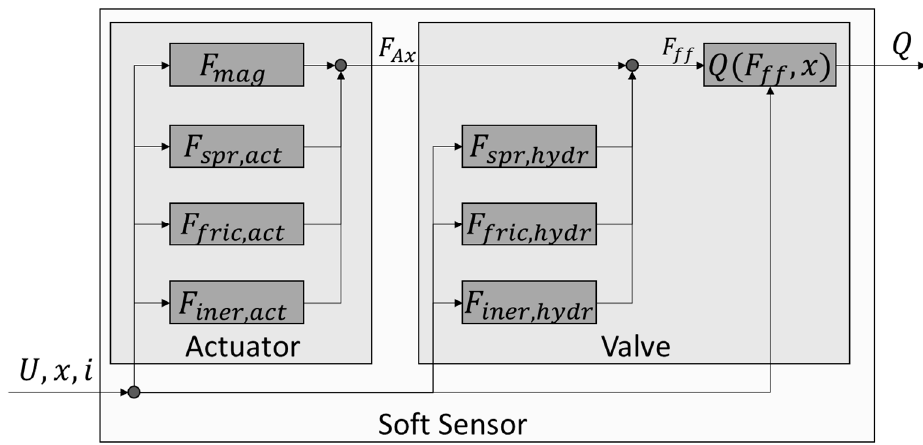
Figure 3. Conceptual Structure of the Soft Sensor.